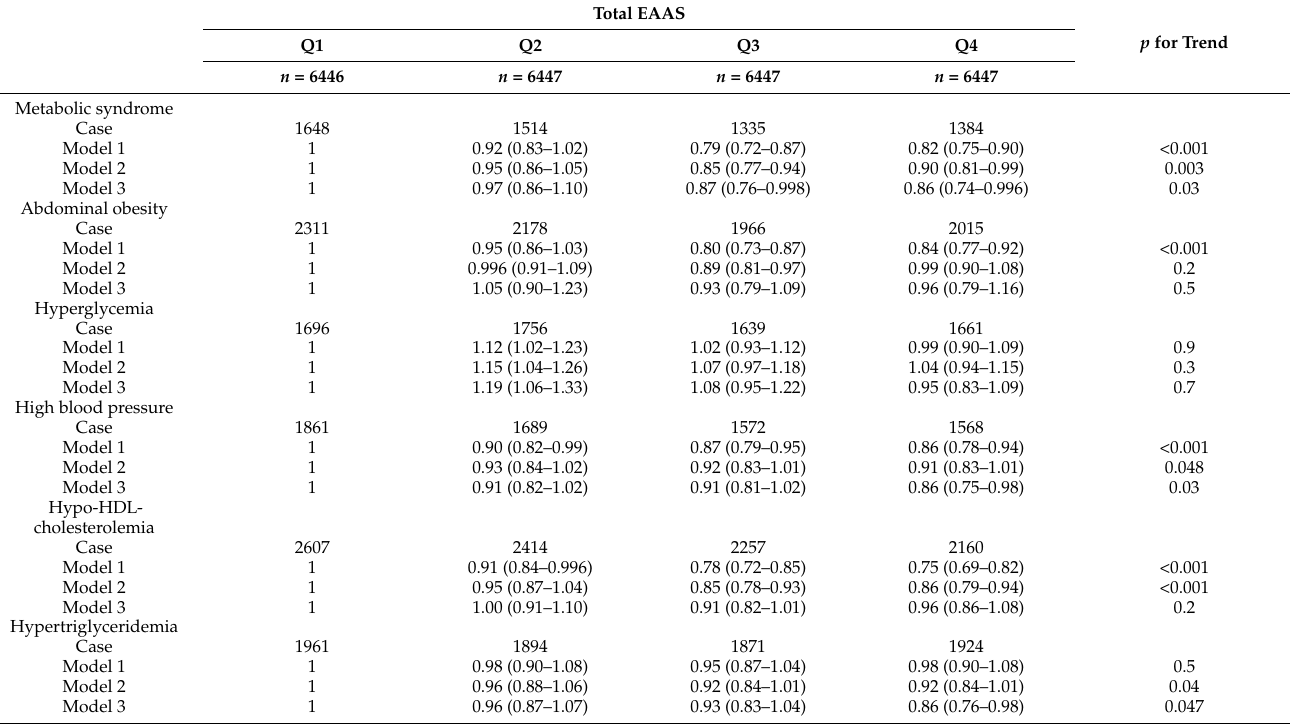
Table 3. The odds ratios and 95% confidence intervals for metabolic syndrome and its components according to the total EAAS, KNHANES 2008–2019 ( n = 25,787).